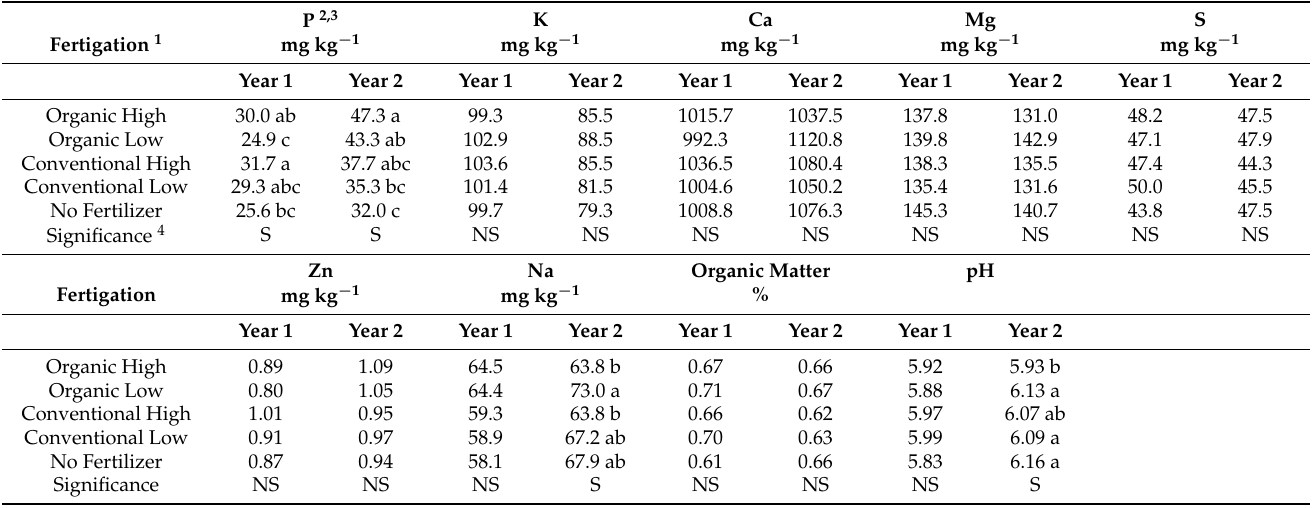
Table 6. Soil-extractable nutrient levels and soil pH in a high tunnel production of zinnia “Benary’s Giant Mix” in response to fertigation treatments. Data were taken 50 days after transplanting in both years.